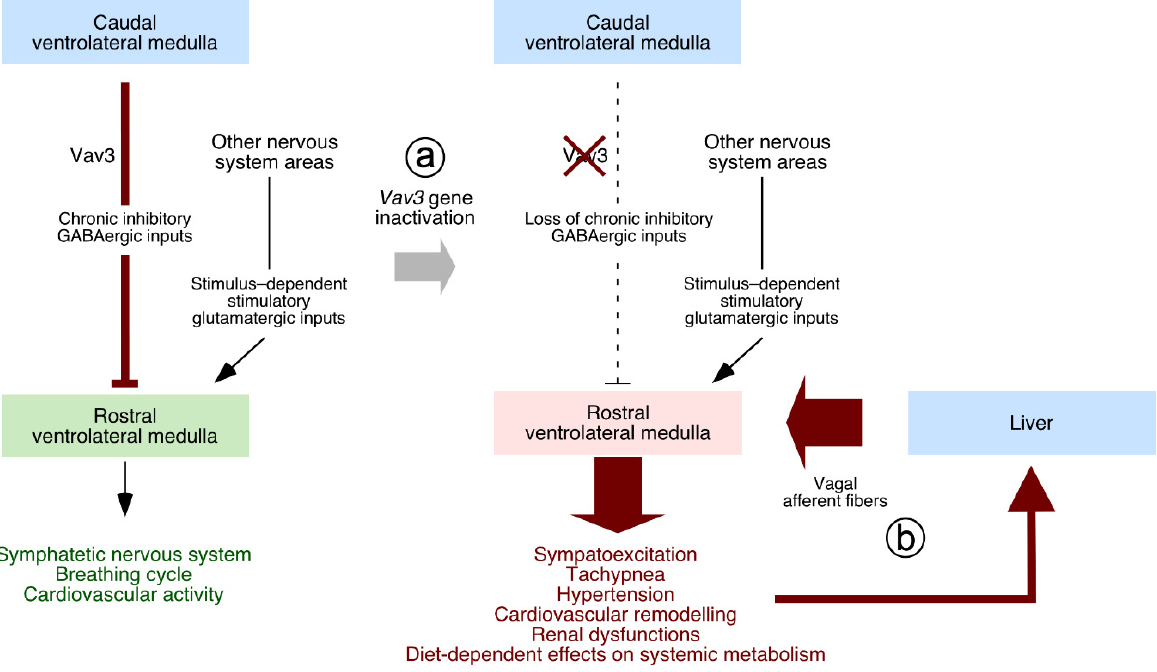
Figure 3. Involvement of Vav3 in the regulation of sympathetic output from the RVLM. Left , normal conditions. Right , sympathoexcitation-induced physiological alterations found in Vav3-deficient mice ( a ). The influence of peripheral stimuli, transmitted to the RVLM using the vagus nerve is shown in ( b ) (see Section 7). Further details are discussed in the main text.